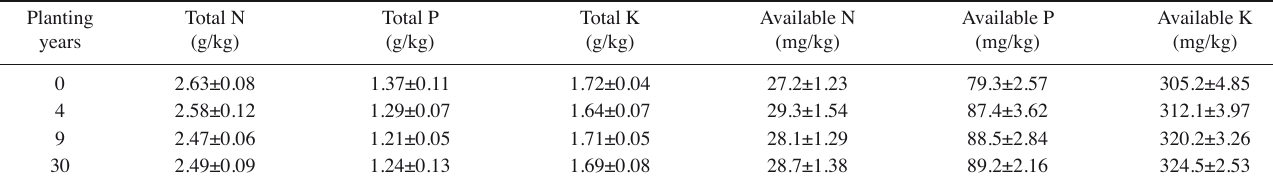
Tab. 1: Physico-chemical properties of tea rhizosphere soil of different ages Planting